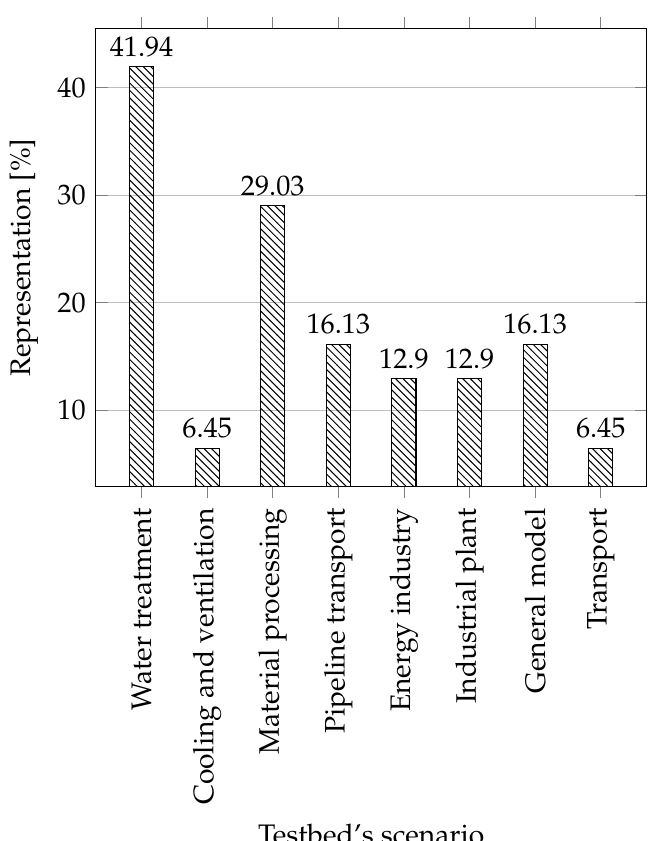
Figure 17. The percentage of selected